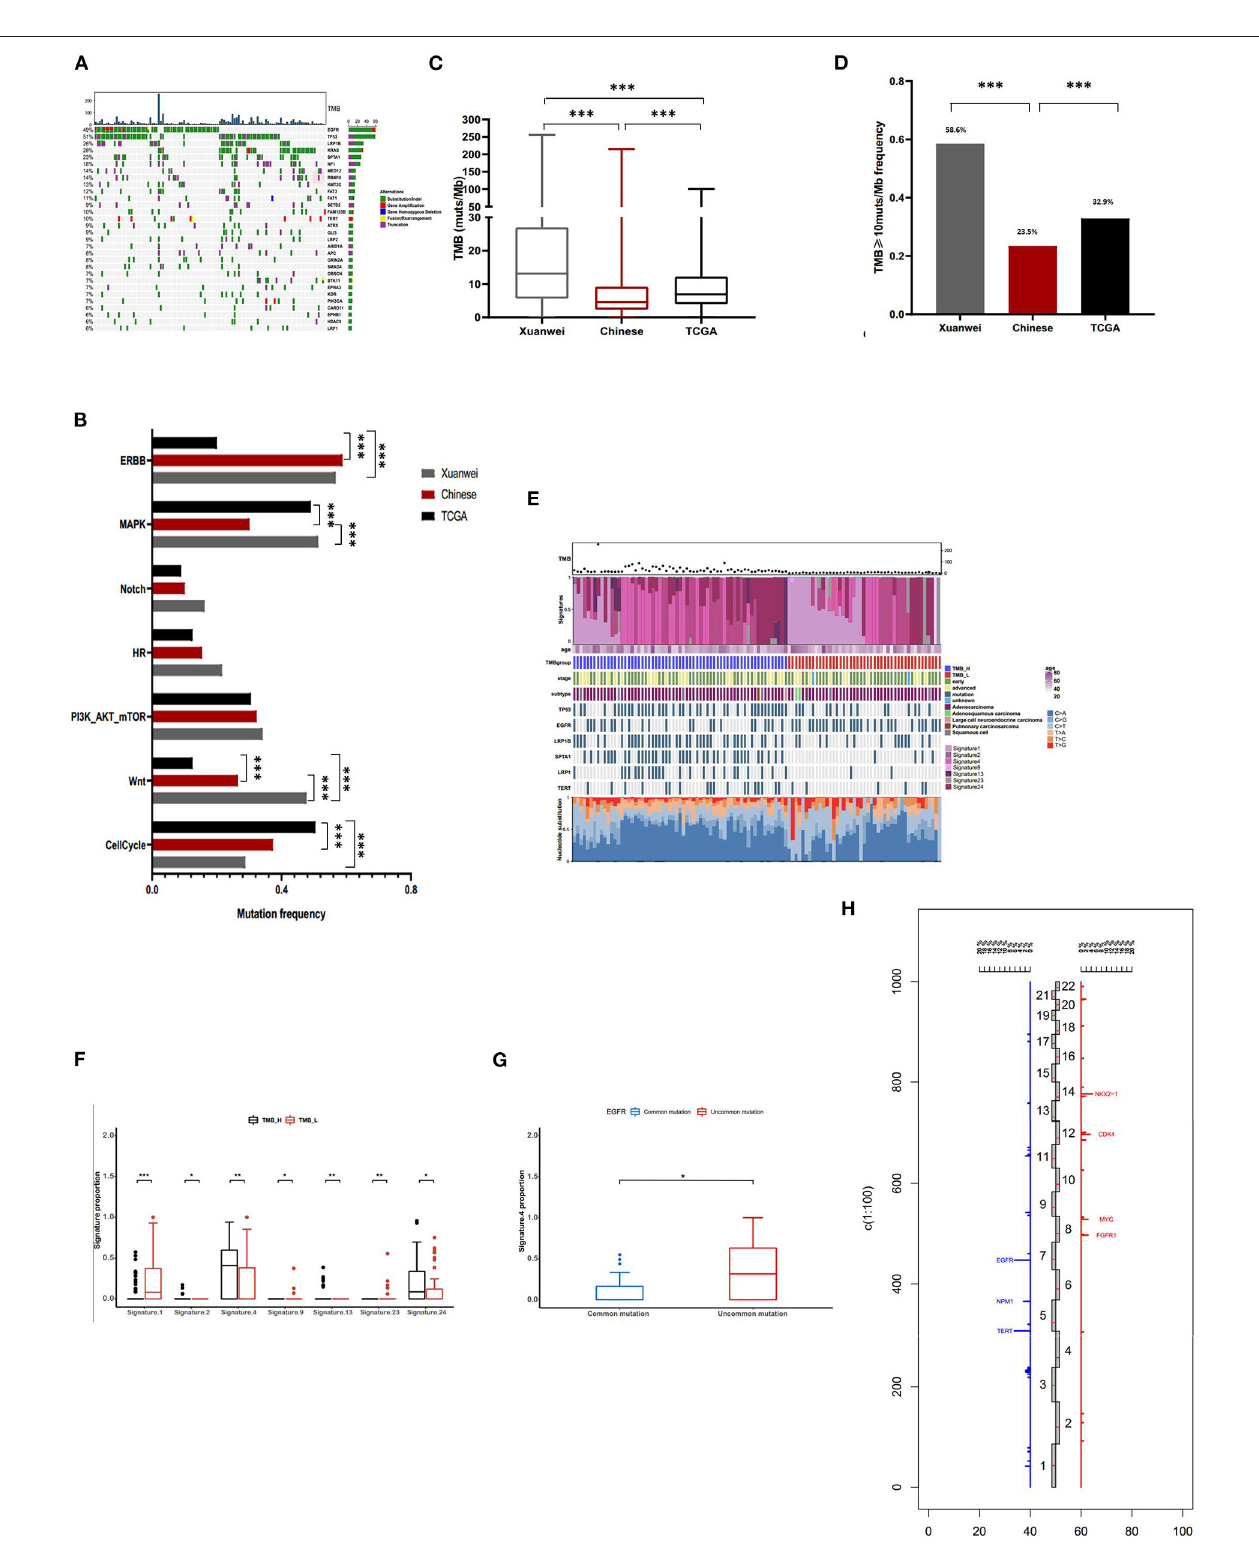
FIGURE 3 | Comprehensive profiling of and somatic mutation signatures in patients from Xuanwei with NSCLC. (A) Comprehensive profiling of 111 patients from the Xuanwei cohort. (B) Comparison of the detection rate of gene mutations in pathways in the three cohorts. (C) Comparison of the proportion of the TMB value and (D) patients with TMB-H. (E) Somatic mutation signatures of the Xuanwei cohort. (F,G) Correlation between TMB value/ EGFR mutation type and mutation signature. (H) Frequency of copy number variations of all chromosomal changes. Numbers 1–22 in the middle represent the human chromosome number. *** p < 0.001, ** p < 0.01, and * p <